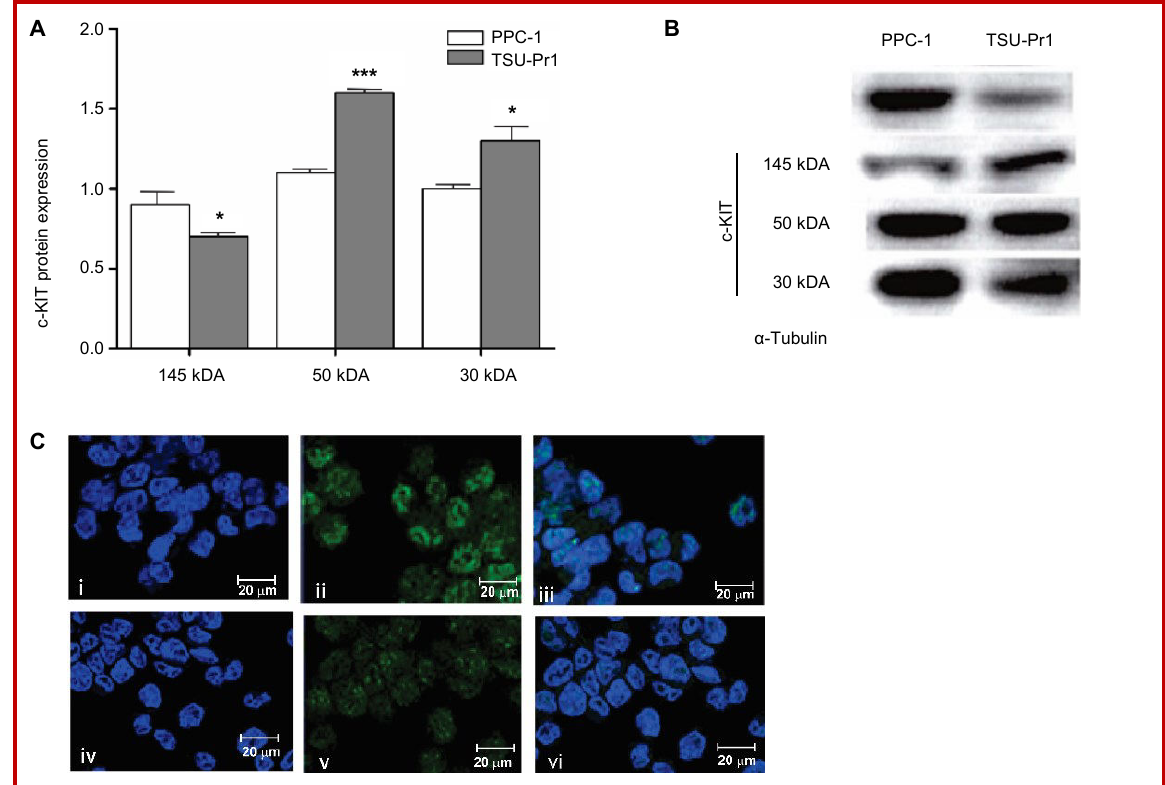
Figure 6: Expression of full-length (145 kDa), and 50 and 30 kDa isoforms of c-KIT in PPC-1 and TSU-Pr1 cells. (A) Expression of c- KIT proteins determined by WB analysis. Representative immunoblots are shown in panel B. (C) Representative confocal micros- copy images showing c-KIT positive staining in PPC-1 and TSU-Pr1 cells. Nuclei are stained with Hoechst 33342 (blue, i and iv), and fluorescence c-KIT-positive staining is green (ii and v). Merged images are shown in iii and